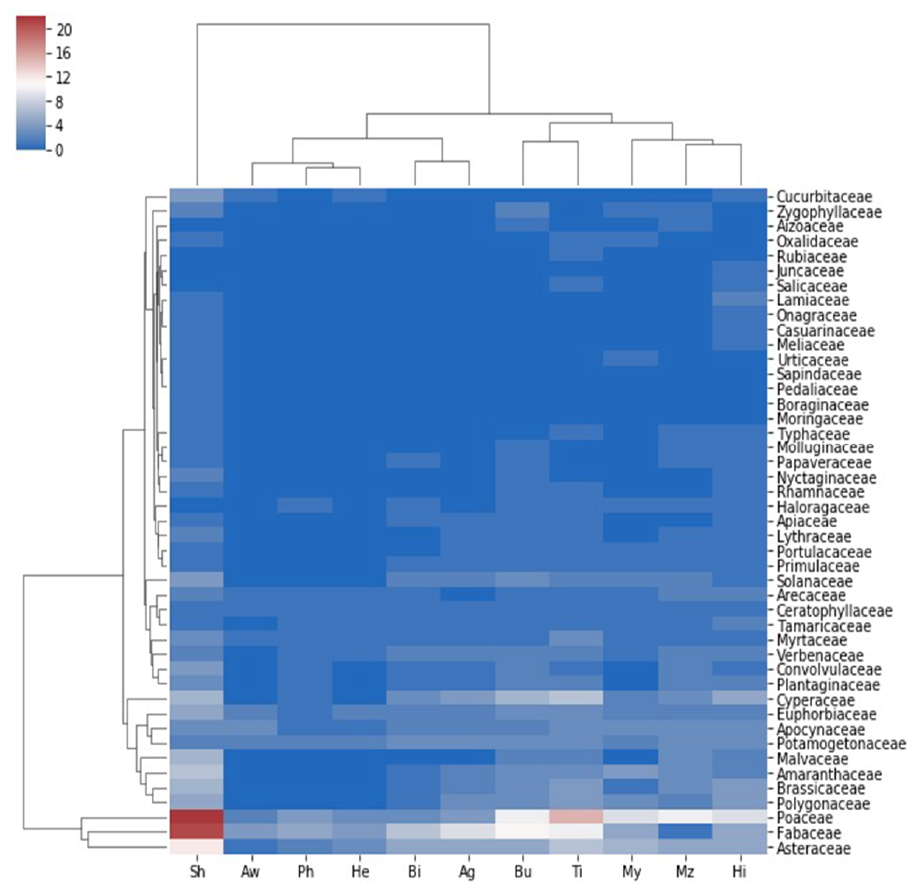
Figure 3. Heatmap illustrating the distribution of families on the different locations surveyed at the Aswan Reservoir area. Sh: El Shallal area, Aw: Awad Island, Ph: Philae Port, He: Heisa Island, Bi: Bigga Island, Ag: Agilkia Island, Bu: Bute El-Hasaya, Ti: Tingar, My: El Mahgar Valley, Mz: Maezana Belal, Hi: High Dam